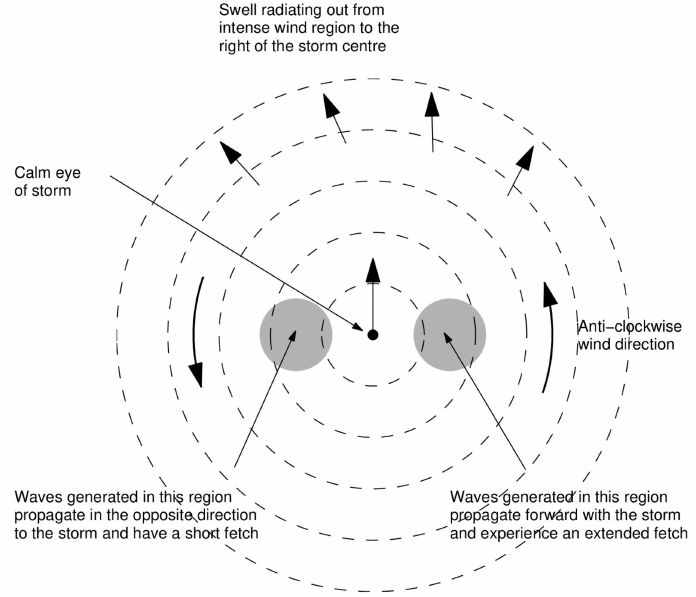
Figure 2. Schematic diagram showing the generation of waves within a translating northern hemisphere tropical cyclone. The tropical cyclone shown is translating “up the page”, as shown by the arrow at the centre of the storm. The wave field is characterized by (i) swell ahead of the storm, radiating out from the intense wind region to the right of the storm centre, and (ii) significant asymmetry caused by the higher winds and extended translating fetch to the right of the storm